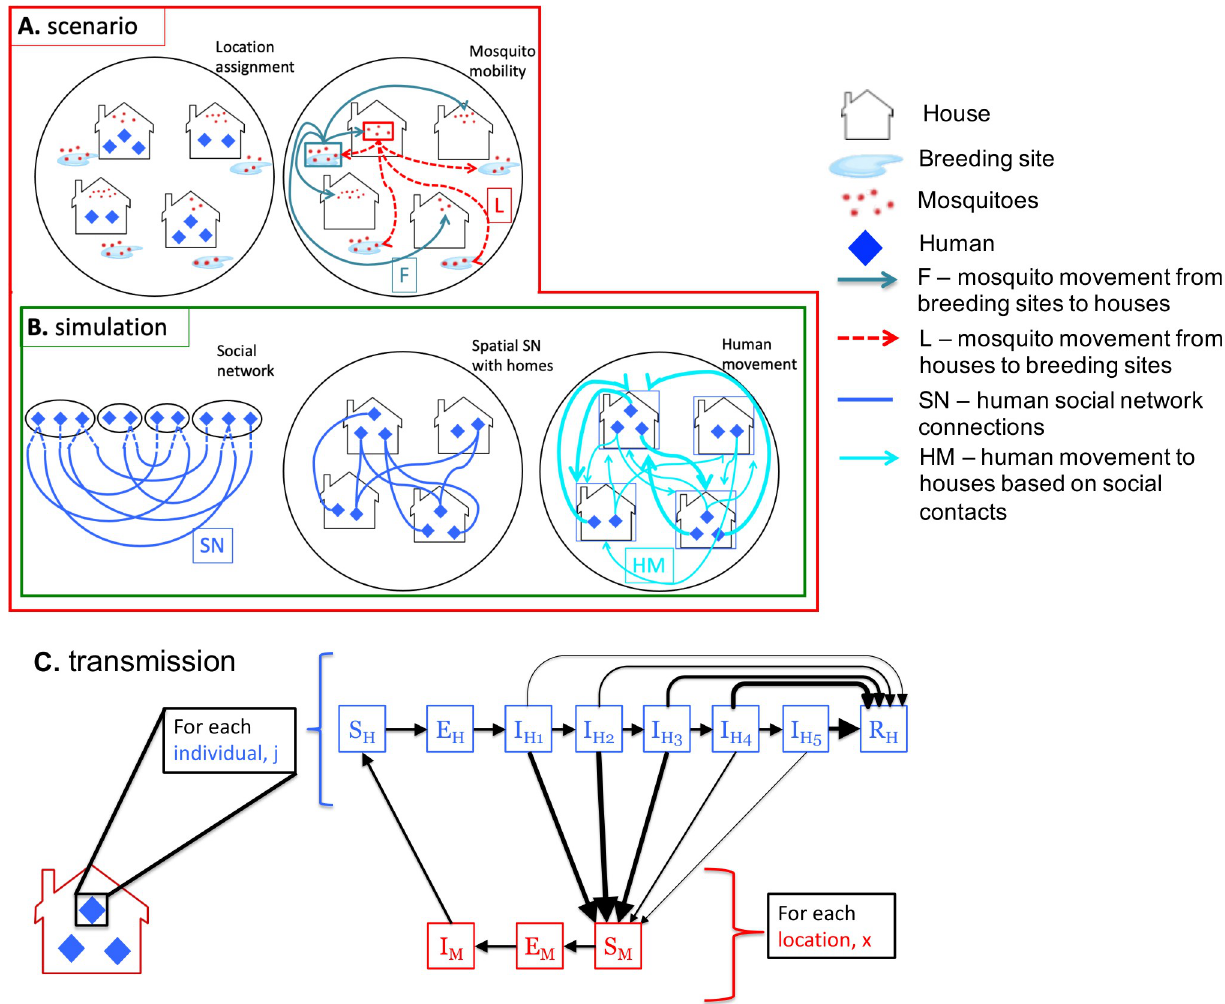
Fig 1. Diagram with setup of model framework for each scenario and simulation run. (A) For each scenario, this model includes houses and larval sites in which mosquitoes breed and move with specific daily probabilities. (B) For each of 200 simulation runs, a random social network ( SN ) is generated for humans, defining their contacts at home and at other houses and further determining the human movement matrix ( HM ). (C) Diagram of our stochastic compartmental transmission model in which mosquitoes at the household level were modeled as SEI (with M subscripts) and humans as an individual-based SEIR (with H subscripts). The I (infectious) stage for humans was divided into five sub-stages, each with their infectiousness value, shown here with weighted arrows. Individuals can either progress to the next (I H ) infectious sub-stage or move straight to the (R H ) recovered stage based i on a probability function. The probability of moving to the recovered stage is shown with weighted arrows (thicker arrows indicate higher